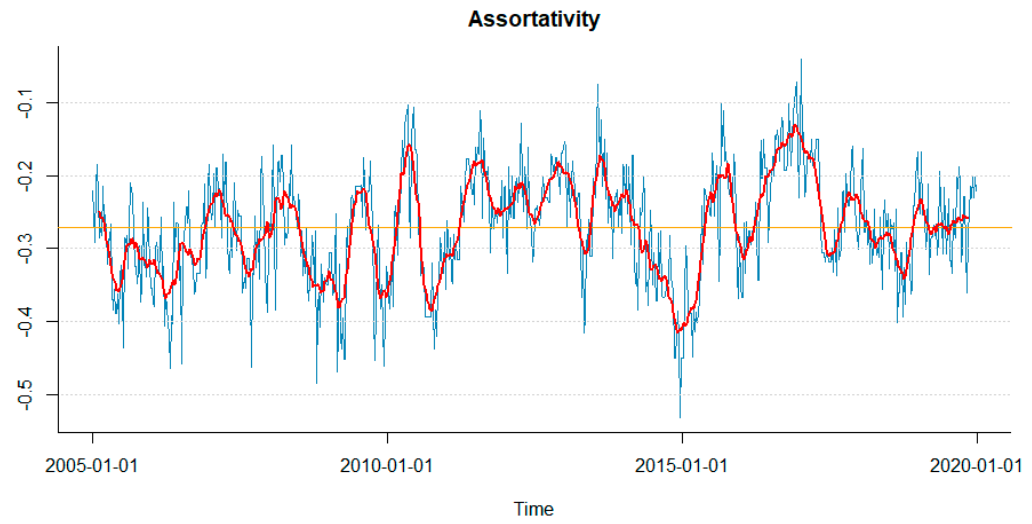
Figure 11. Assortativity during the period from 7 January 2005 to 20 December 2019. Red lines depict the 13 periods of the moving average smoothed series. Source: Own study.